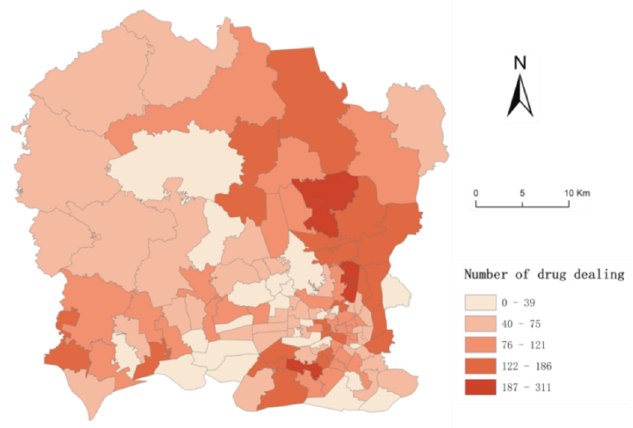
Figure 1. Distribution of drug dealing in ZG city between 2012–2018 .